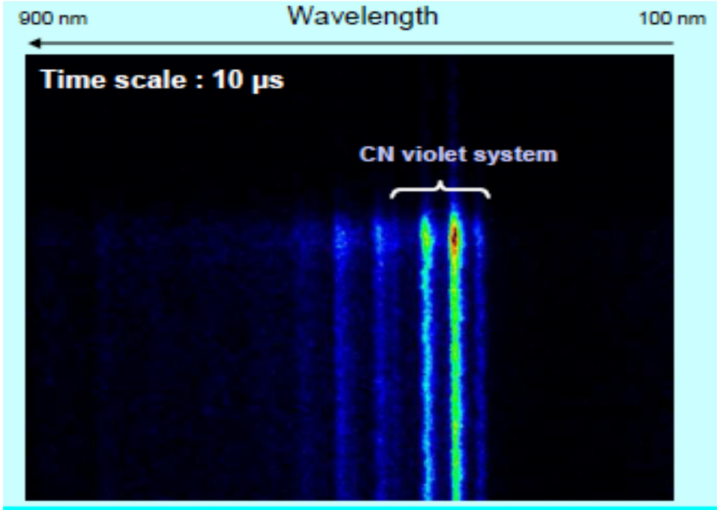
Figure 55. Streak image for Case 1 of Table 6 (from